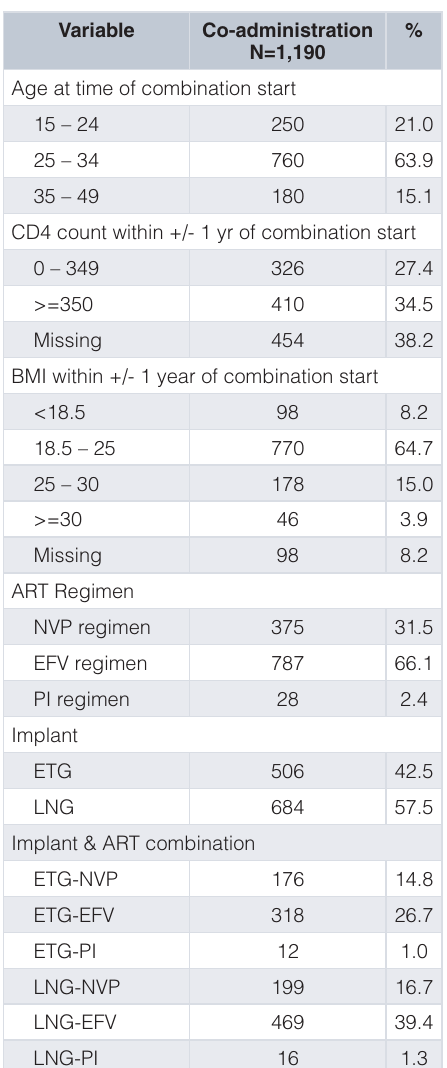
Table 2. Age and clinical status of women at the start of each observation of each co-